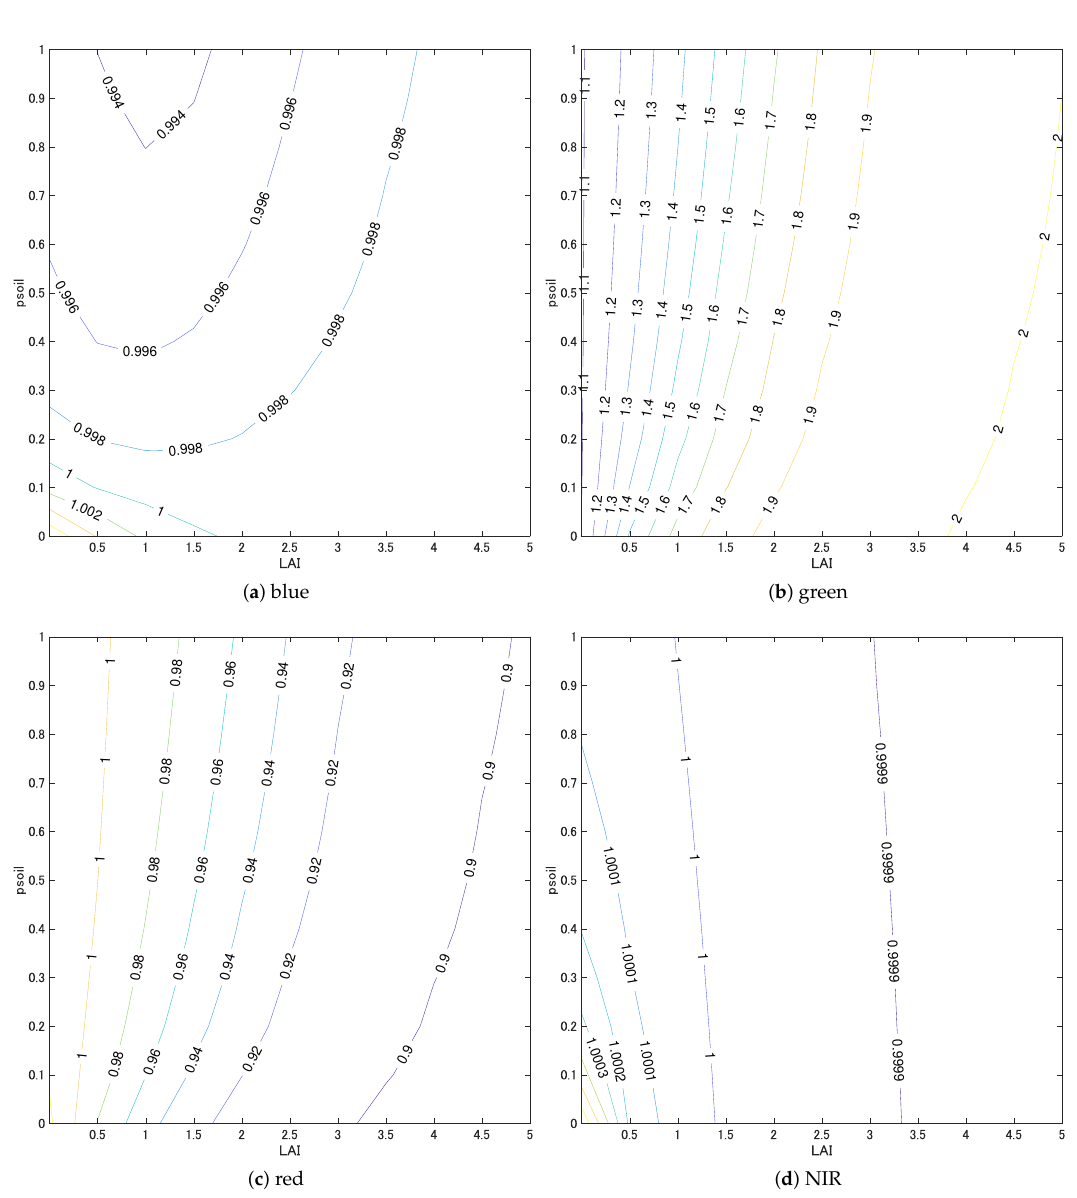
Figure 11. Contour plots of the simulated MODIS to AHI reflectance ratios for ( a ) blue, ( b ) green, ( c ) red, and ( d ) NIR bands as a function of LAI and soil moisture surface effects. Ratios were close to 1.0 in the blue and NIR bands, whereas ratios were much higher than 1.0 in the green band and were smaller than 1.0 in the red